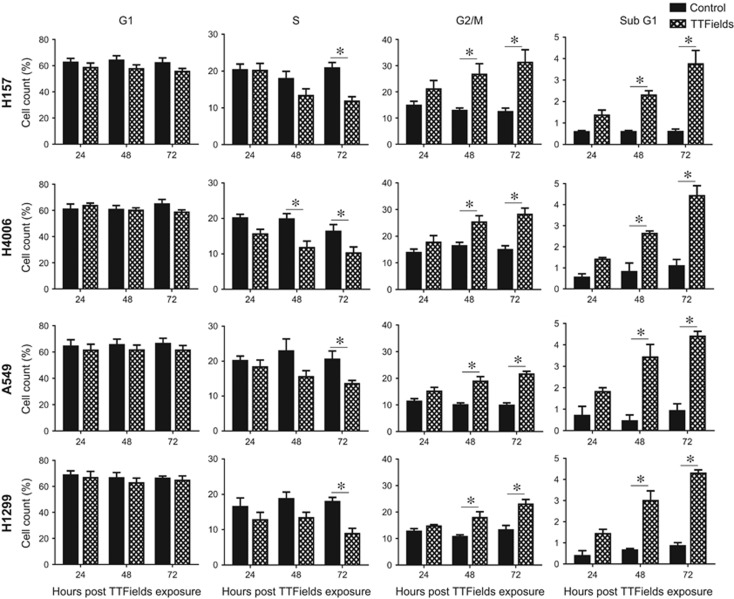
TTFields alter cell cycle distribution. TTFields treatment resulted in a significant enrichment of NSCLC cells in the G2/M phase of the cell cycle, a decrease in the percentage of cells in S-phase, and resulted in the significant induction of a sub-G1 population indicative of an apoptotic cell population. Error bars represent the S.E.M. of three separate experiments and asterisks represent significant changes (P<0.05) in cell count percentage at given time point and cell line